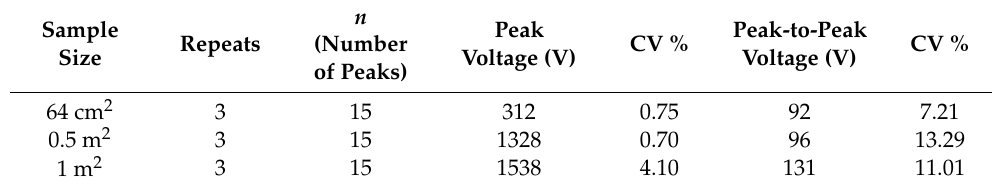
Table 6. Effect of sample size on the electrostatic charge generation.